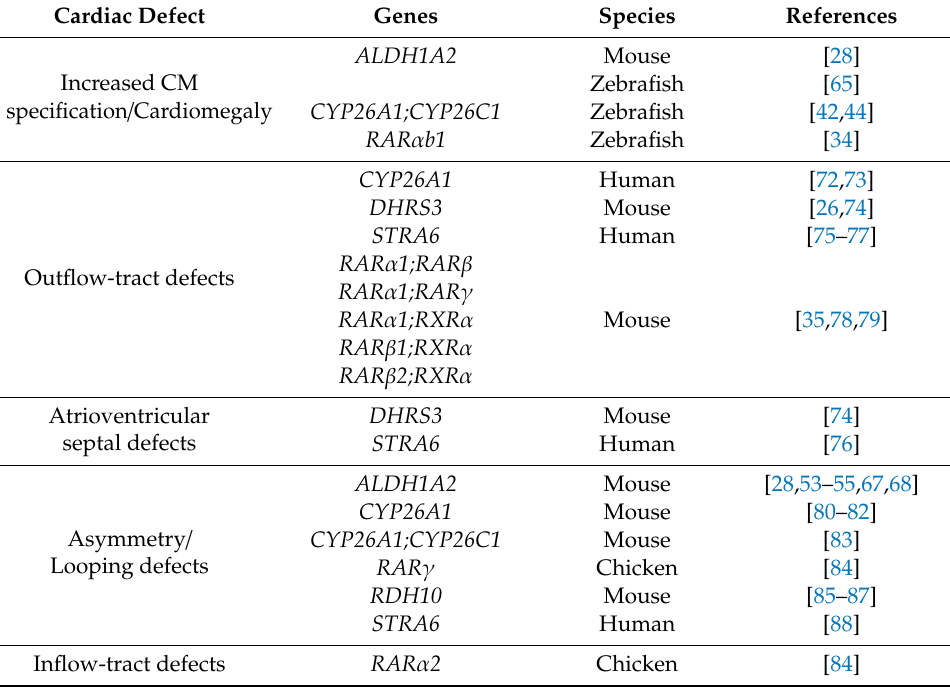
Figure 3. Schematic depicting restriction of CM specification by RA signaling. Levels of RA are indicated by blue arrows. Loss of RA results in a marked expansion of both chambers ( A ) compared to wildtype hearts ( B ). High doses of RA can inhibit the specification of both ventricular and atrial CMs ( C ), even completely eliminating cardiac specification with the highest dosages. While extremes of RA signaling perturbation are depicted here, progressive increases in RA signaling can cause differential effects on ventricular and atrial specification. The schematic depicted is primarily derived from studies in zebrafish. Table 1. Cardiac defects arising from loss of RA signaling